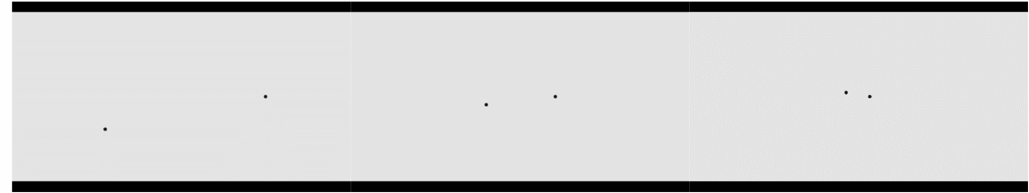
Figure 1. Screenshots of one scenario at three moments. Left : Beginning of the video, Middle : 10 s into the video, Right : 15 s into the video. This is a non-conflict scenario, with a conflict angle of 150 deg. After each scenario, participants indicated to what extent they agreed with the statement: “The task was di ffi cult” on a scale from 0 (completely disagree) to 10 (completely agree). Next, the participant was shown his / her performance score for that scenario. The performance score was computed as